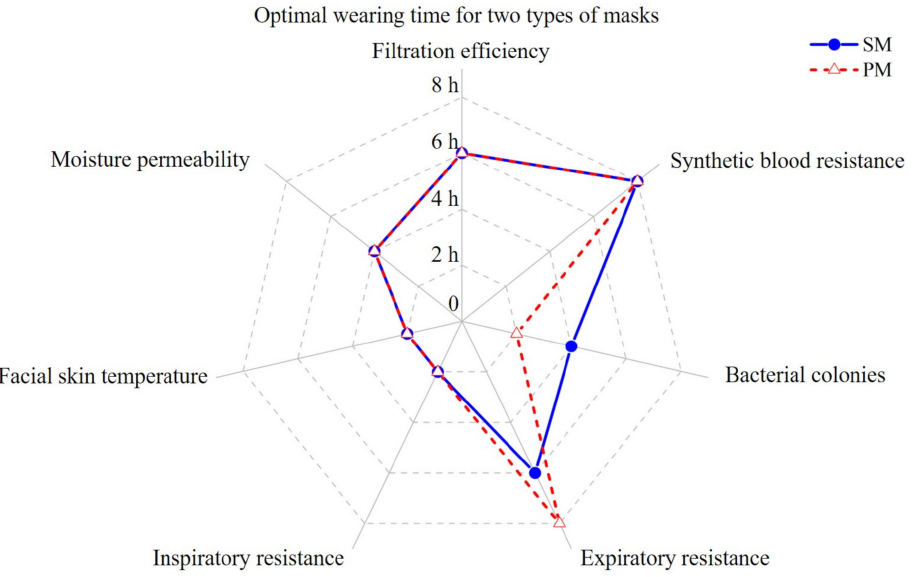
Figure 13. Optimal wearing time for two types of